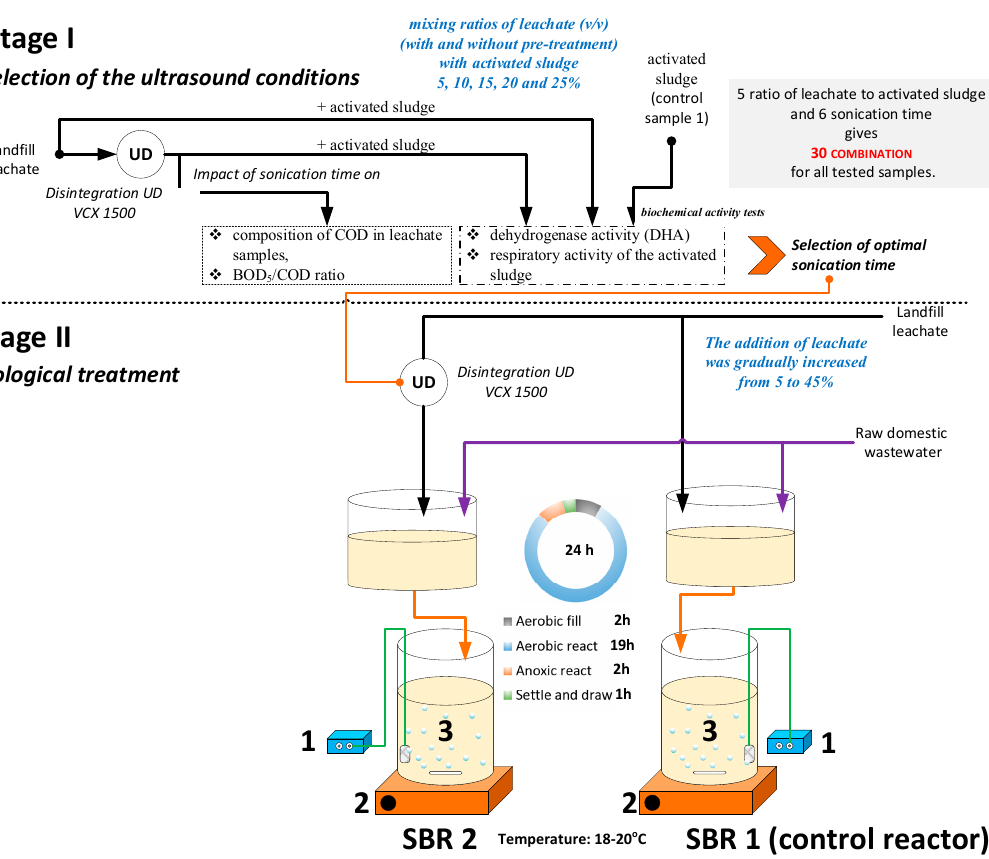
Figure 1. Experimental set-up and operational modes of the SBR; where: 1—Air pomp, 2—Magnetic stirrer,